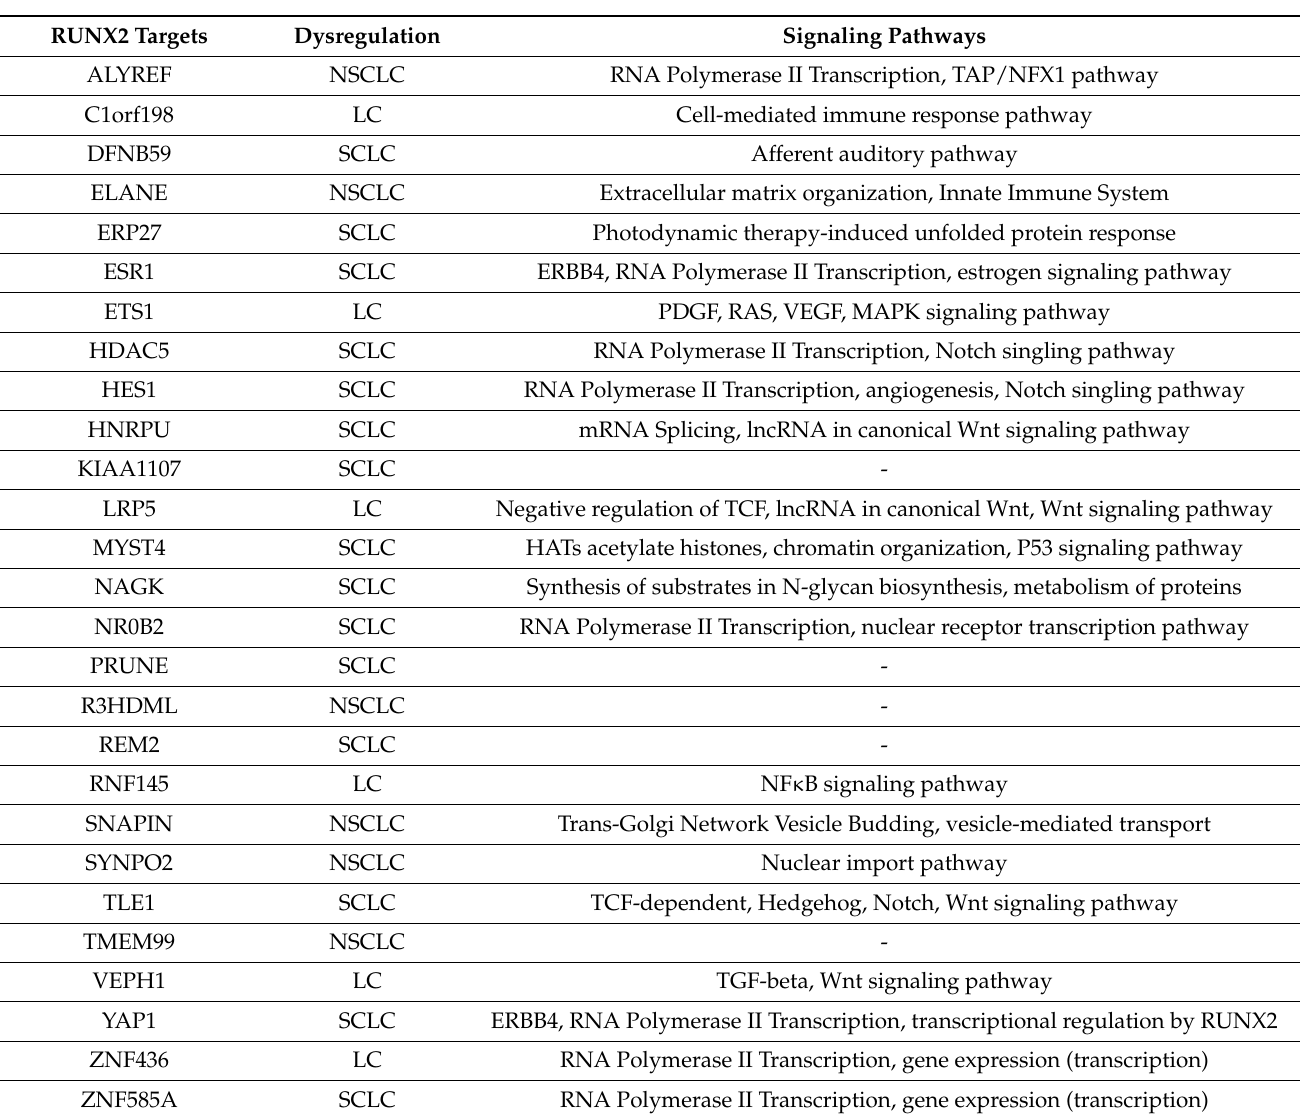
Table 2. Potential direct targets of RUNX2 deregulated in lung cancer (LC), non-small-cell lung cancer (NSCLC), and small-cell lung cancer (SCLC) and the signaling pathways associated with its regulatory